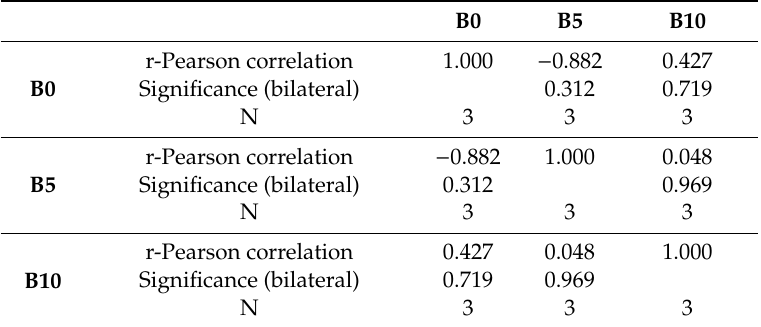
Table 10. Results of the r-Pearson correlation of concrete composite after 28